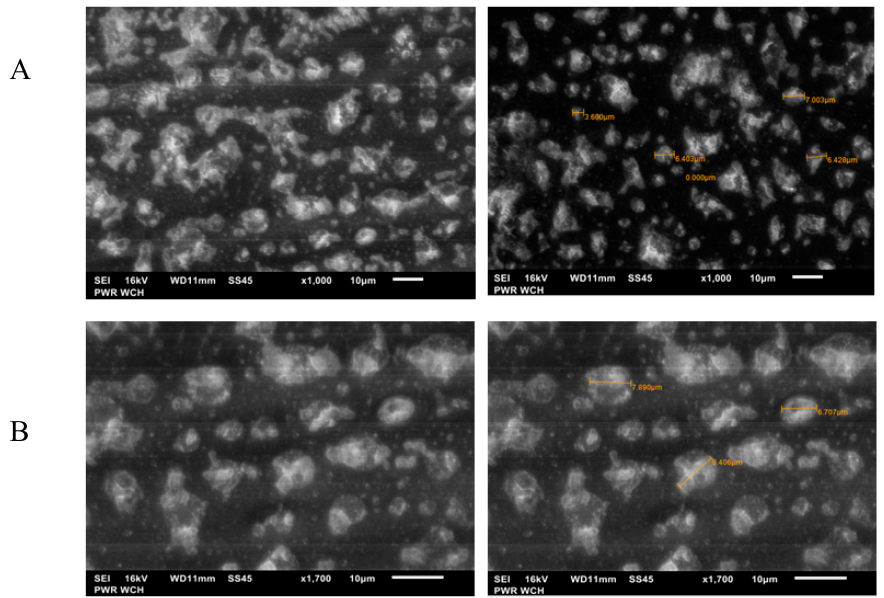
Figure6. Representativescanningelectronmicroscopy(SEM)imagesofelectrodesurfacesmodifiedwith Figure 6. Representative scanning electron microscopy (SEM) images of electrode surfaces modified 2,6-bis(3,4-ethylenedioxythiophene)-4-methyl-4-octyl-dithienosilole ( A ) and 2,6-bis(selenophen-2-yl)- with 2,6-bis(3,4-ethylenedioxythiophene)-4-methyl-4-octyl-dithienosilole ( A ) and 4-methyl-4-octyl-dithienosilole ( B ). Scale bar: 10 µ 2,6-bis(selenophen-2-yl)-4-methyl-4-octyl-dithienosilole ( B ). Scale bar: 10 μ m.